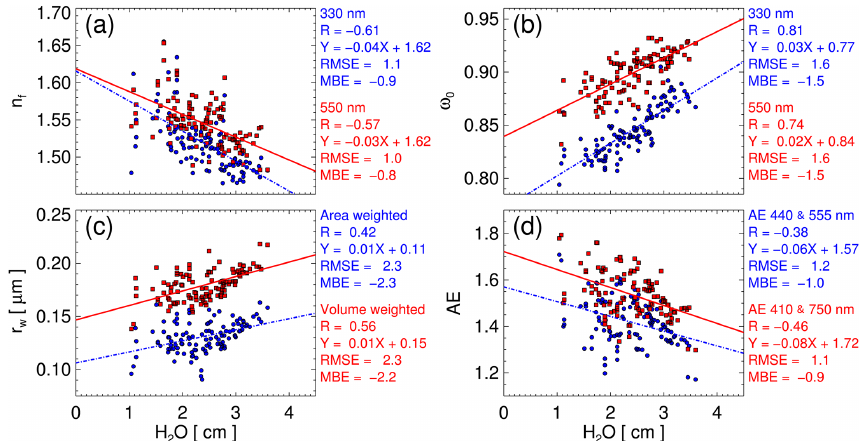
Figure 11. Relationship between aerosol properties and column-precipitable H 2 O retrieved from SMART–s over Fang, Thailand, from 19 March to 2 May 2019. Panels (a) and (b) compare the real part of the refractive index of the fine mode ( n f ) and aerosol single scattering albedo ( ω 0 ) to H 2 O, respectively. For the upper panels, blue and red represent n f and ω 0 at 330 and 550nm, respectively. Panels (c) and (d) compare the weighted mean radius ( r w ) and Ångström exponent (AE) to the column precipitable H 2 O, respectively. The blue and red symbols in panel (c) represent the area- and volume-weighted mean radius, and those in panel (d) indicate different wavelength pairs for the AE calculations (blue at 440 and 555nm and red at 410 and